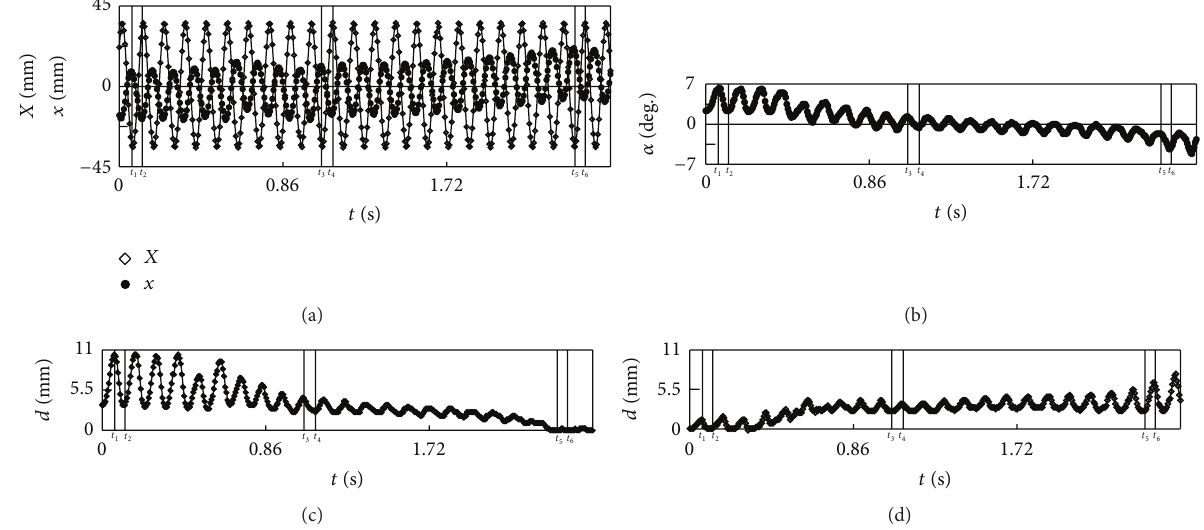
Figure 12: Characteristics of the body oscillation versus the time at point III (Figure 10), 𝑓 = 9.0 Hz.